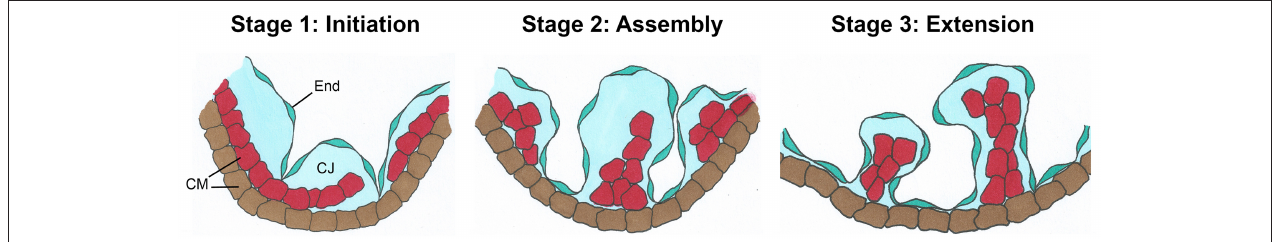
FIGURE 2 | Schematic view of the three basic stages of trabeculation. Initiation (Stage 1) involves delamination of the innermost layer of cardiomyocytes (CMs, red) into the lumen where they form sheet-like protrusions called myocardial lamina. The endocardium (End) sends out angiogenic extensions, or sprouts, that penetrate the cardiac jelly (CJ) to directly touchdown onto the outer mycardial layer (brown). During Assembly, (Stage 2), endocardial sprouts first extend laterally underneath the myocardial lamina. Later they will assemble into individual short trabecular clusters within bubbles of cardiac jelly. Finally, in Stage 3, long sheet-like trabecular structures are formed by Extension [adapted from Qu et al.